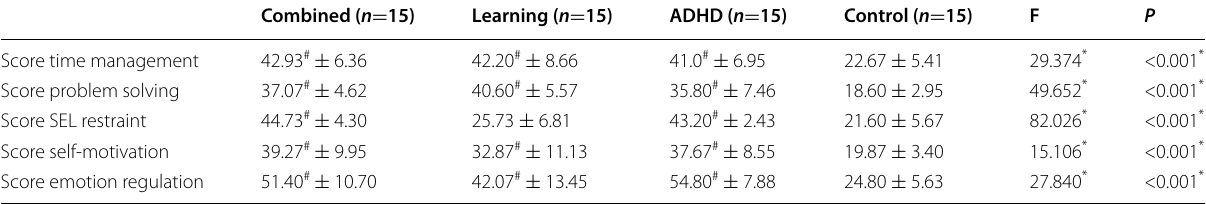
F: F for One way ANOVA test, Pairwise comparison bet. each 2 groups was done using Post Hoc Test (Tukey) p: P value for comparing between the different studied groups *: Statistically significant at p 0.05 ≤ #: Sig. with